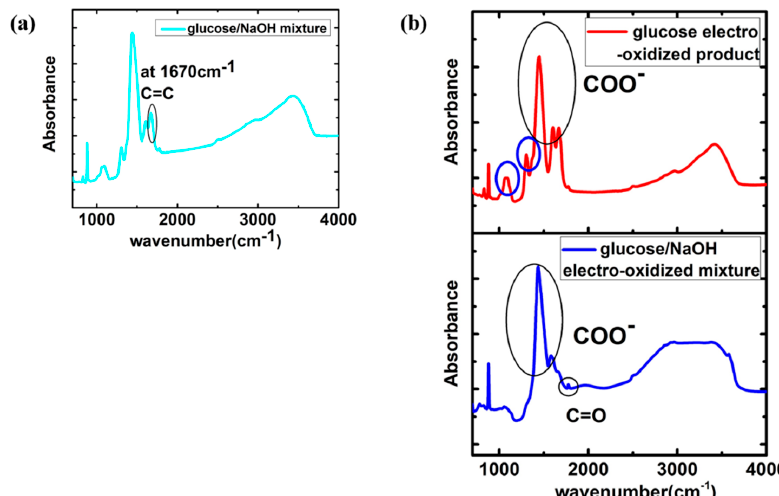
Figure 3. ( a ) Fourier-transform infrared spectroscopy (FTIR) results of glucose/NaOH mixture; ( b ) FTIR results of a pure glucose electro-oxidized product and glucose/NaOH electro-oxidized mixture were measured by FTIR.